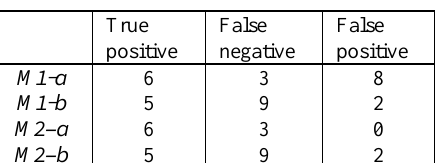
Table 4. Region based evaluation of change detection results for the two test